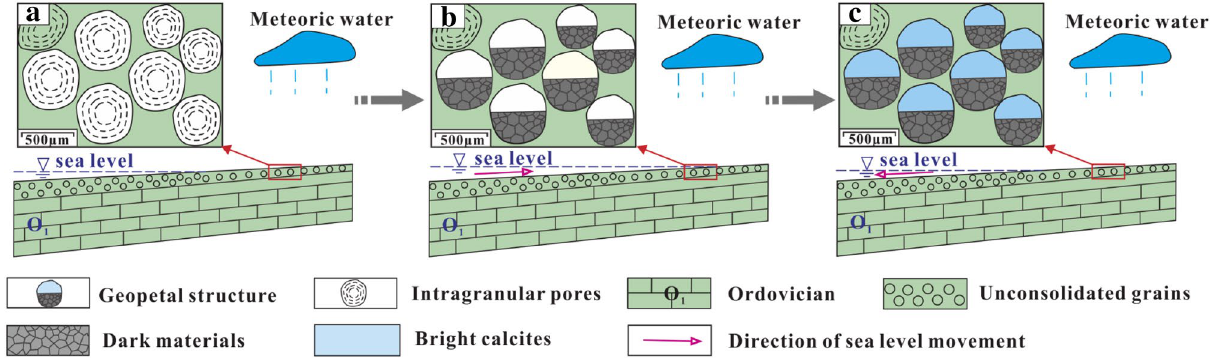
Figure 12. Development model of geopetal structure: ( a ) Intragranular pores formation; ( b ) Dark materials was deposited at the bottom of the intragranular pores; ( c ) Bright calcites was deposited on the upper parts of the dark